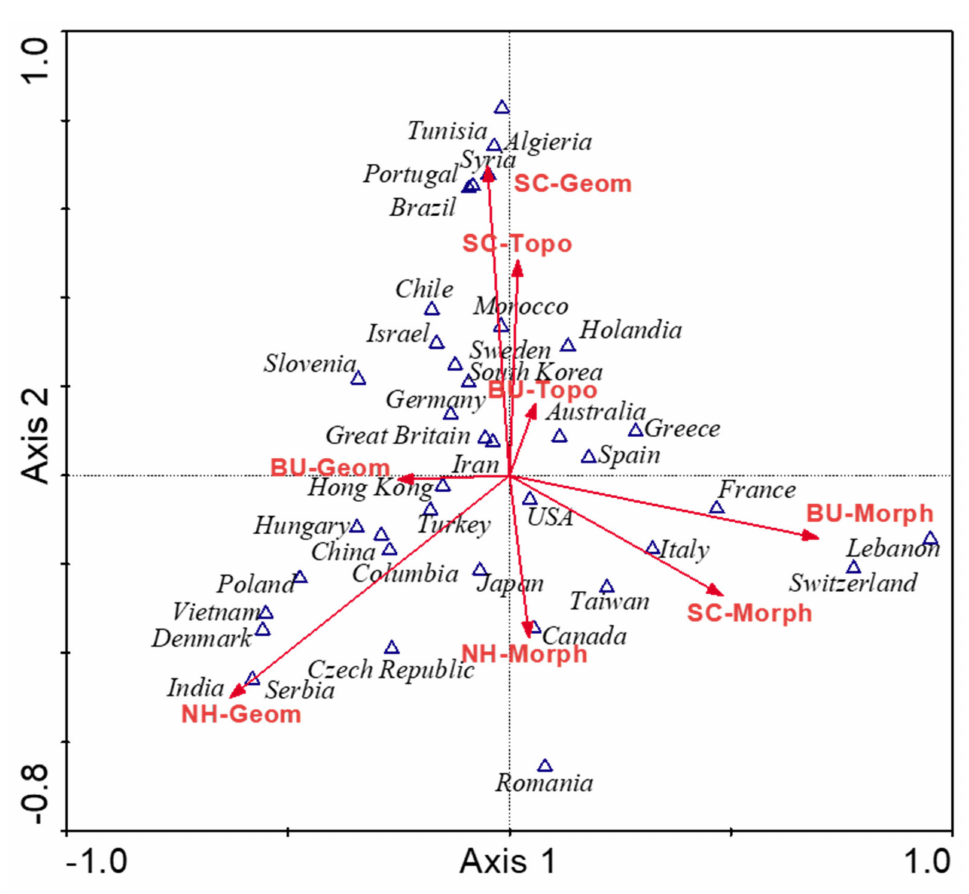
Figure 4. The canonical correlation analysis (CCA) ( n = 948). Relationships between the research frequency and parameter families in selected countries based on papers included in the